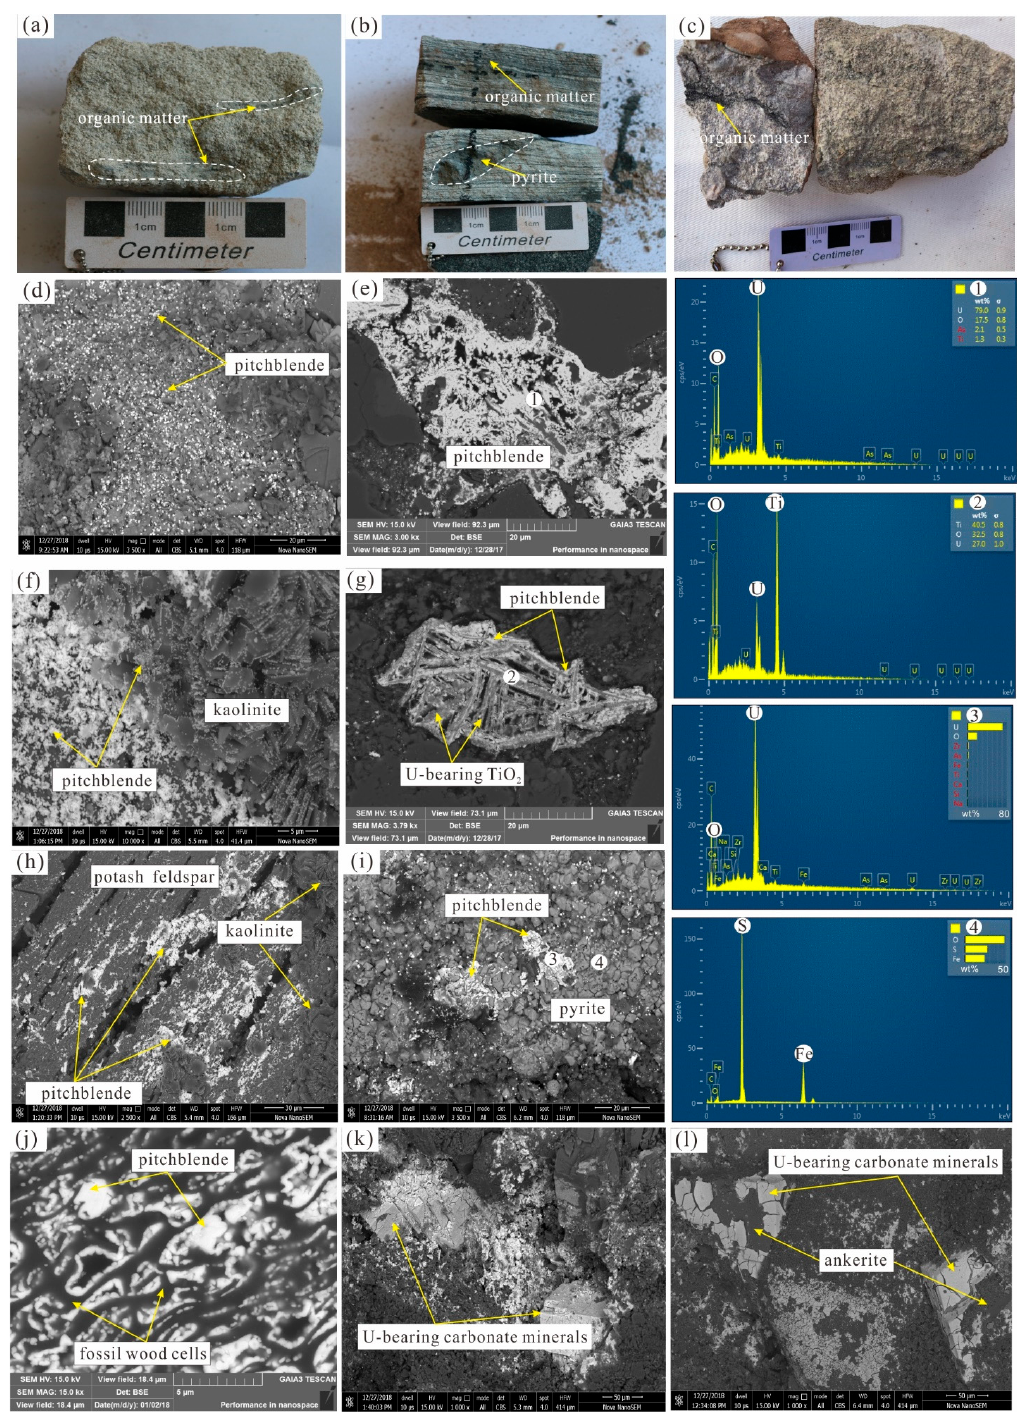
Figure 3. Back scattered electron (BSE) images showing the U occurrence in ore-bearing sandstone of BLS U deposit. ( a ) Gray-white calcareous ore-bearing medium sandstone, containing a small amount of organic matter; ( b ) Gray calcareous ore-bearing fine sandstone, containing pyrite and organic matter; ( c ) Gray calcareous ore-bearing gravelly coarse sandstone, containing organic matter; ( d ) Fine pitchblende adsorbed on fine sediments between particles; ( e ) Pitchblende aggregates occurring in in- tergranular pores; ( f ) Fine pitchblende adsorbed on kaolinite; ( g ) U-bearing TiO 2 ; ( h ) Fine pitchblende adsorbed in pores of potash feldspar and on kaolinite; ( i ) Pitchblende aggregates around pyrite in intergranular pores; ( j ) Fine pitchblende in fossil wood cells; ( k ) U-bearing carbonate minerals in intergranular pores; ( l ) U-bearing carbonate minerals around ankerite in intergranular